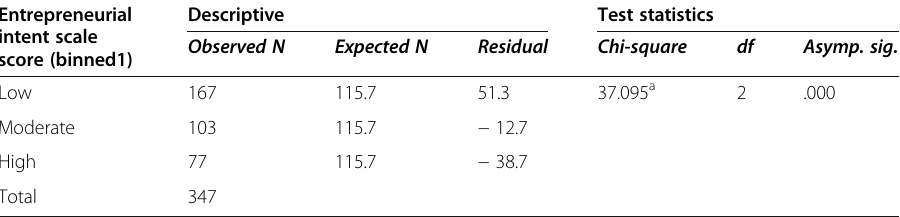
Table 1 Chi-square goodness of fit test result on the level of entrepreneurial intent Entrepreneurial intent scale score